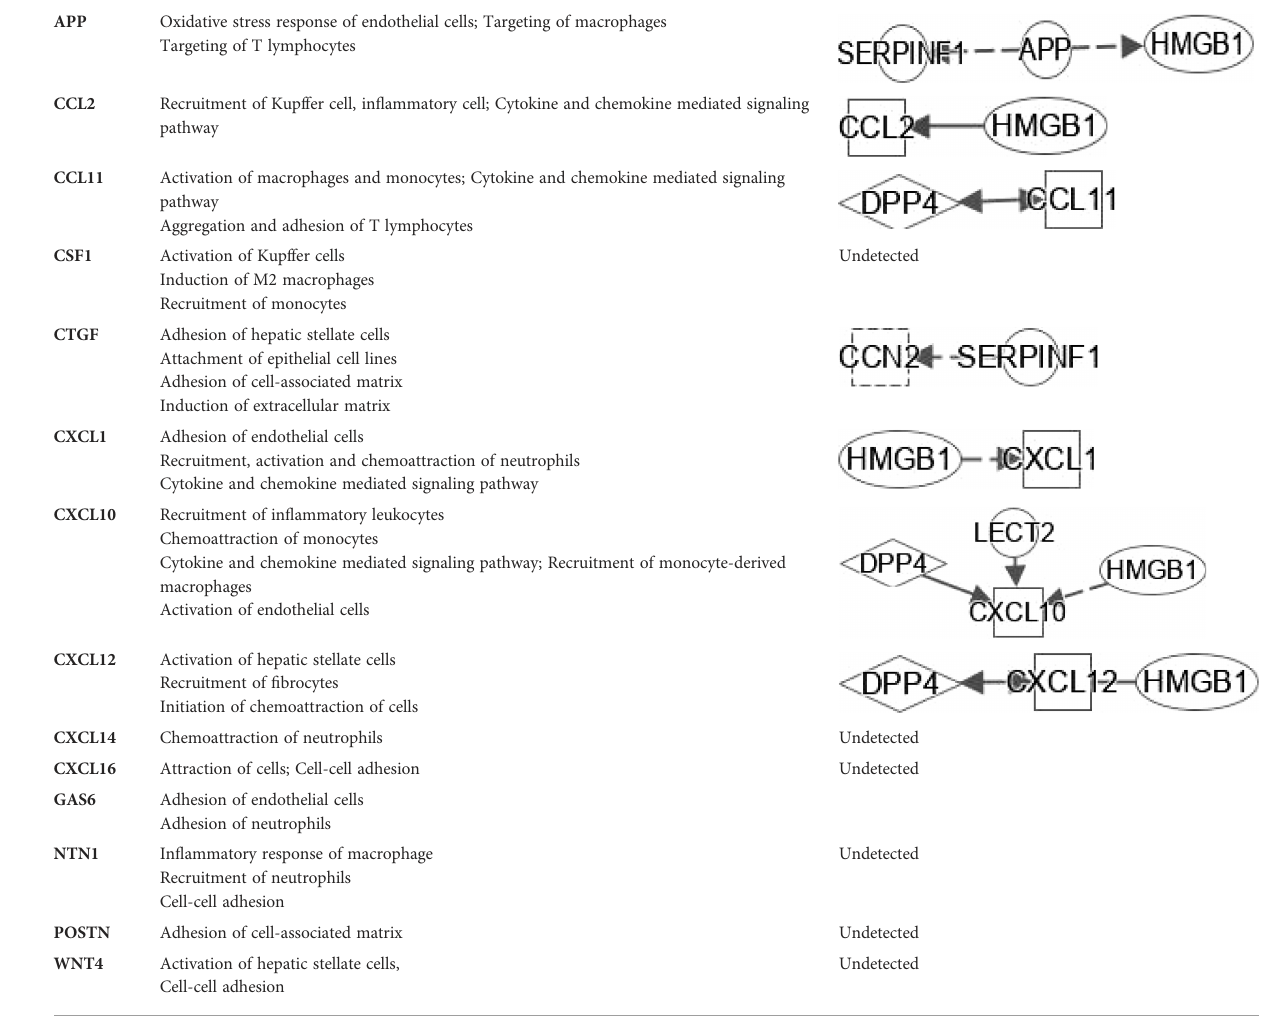
TABLE 3 IPA analysis of Cell-cell signaling and interaction of HSC-derived stellakines. Stellakine Cell-cell signaling and interaction Interaction between adipokine and